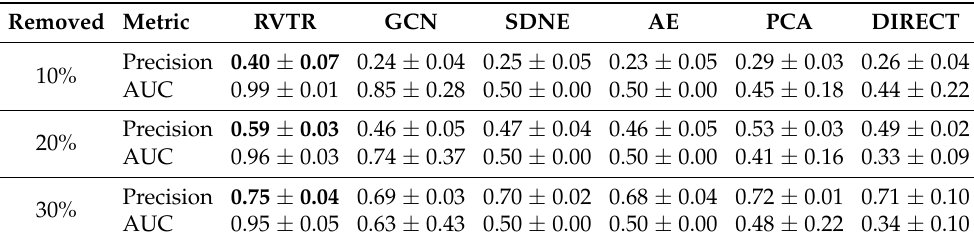
Table 6. The results in the Australia dataset (training and testing both on the Australia dataset). The tests were performed on 10%, 20% and 30% nodes removed, respectively.